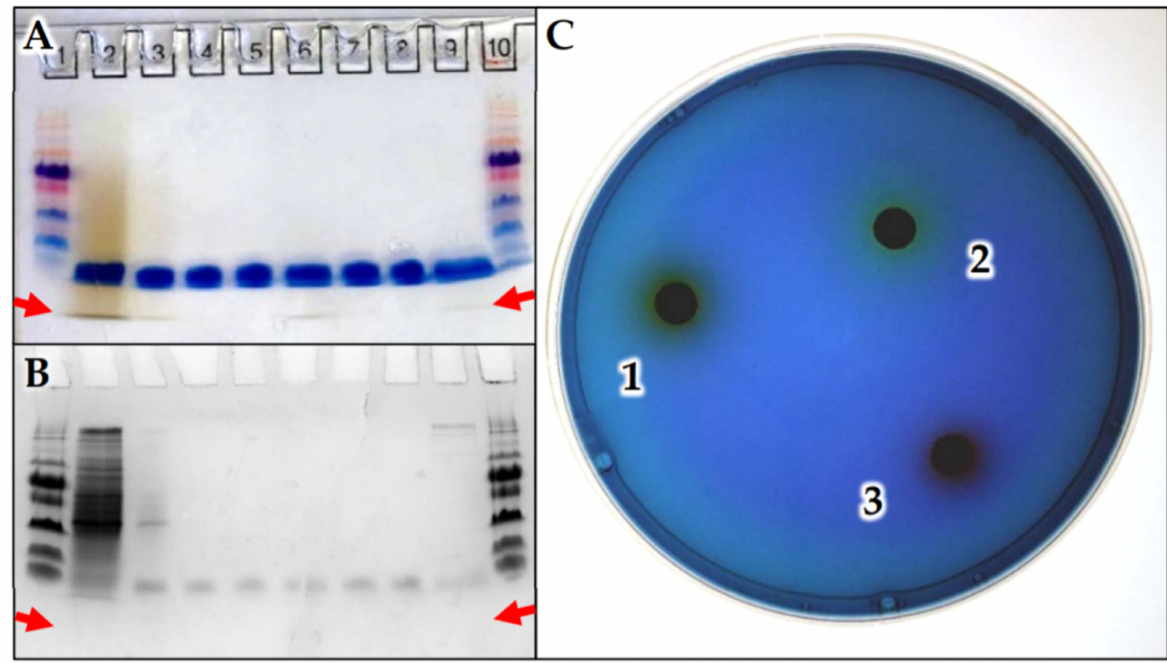
Figure 3. Gel purification of C. halotolerans brown pigment, and confirmation of siderophore activity. ( A ) Unstained and ( B ) stained tris-tricine gel electrophoresis performed on: siderophore from resin concentration, wells 2–5; siderophore sample smaller than 3 kDa, wells 6–8; proteins larger than 3 kDa and remaining in solution well 9; standard ladder, wells 1 and 10. ( C ) Siderophore activity observed for: (1) Crude resin extract positive reaction visible as yellowing area; (2) <3 kDa dark brown fraction produced positive yellowing reaction; (3) Proteins >3 kDa negative results observed as darkening of blue due to alkaline pH, without siderophore activity